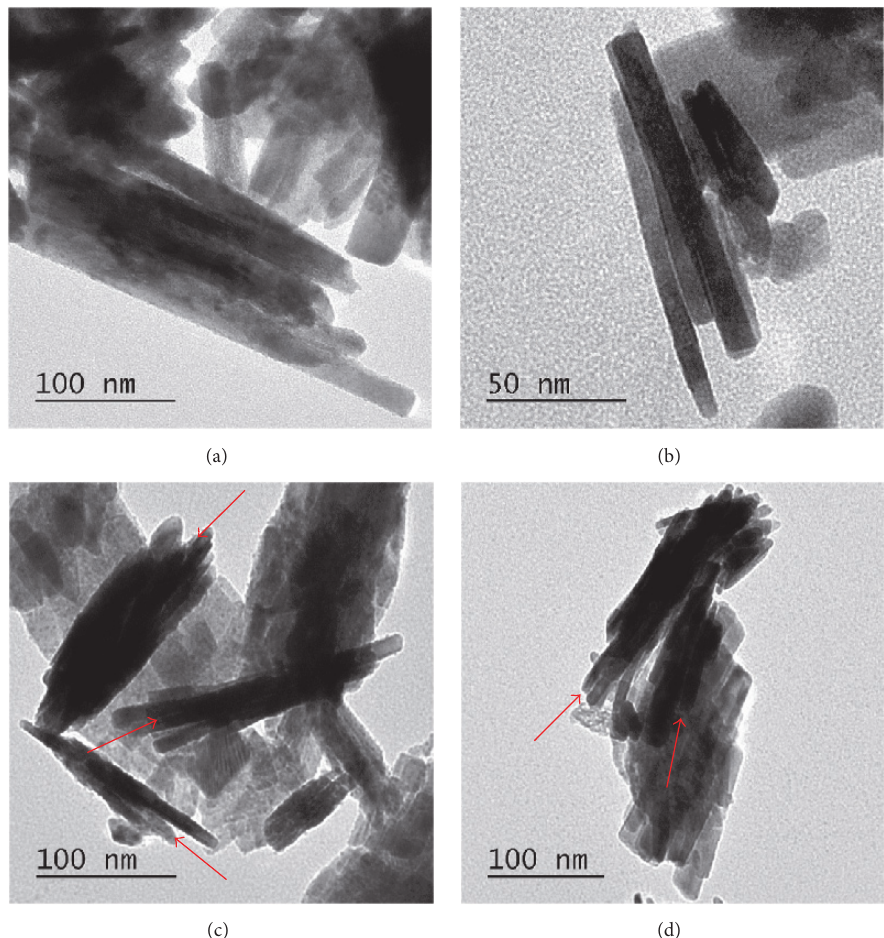
Figure 3: TEM images of CdWO 4 nanorods produced with varied conditions: using reagents in stoichiometric proportion, soaking time of (a) 20 min and (b) 60 min, or using Cd excess of (c) 20% and (d) 30%. Some nanofiber bundles are indicated by red